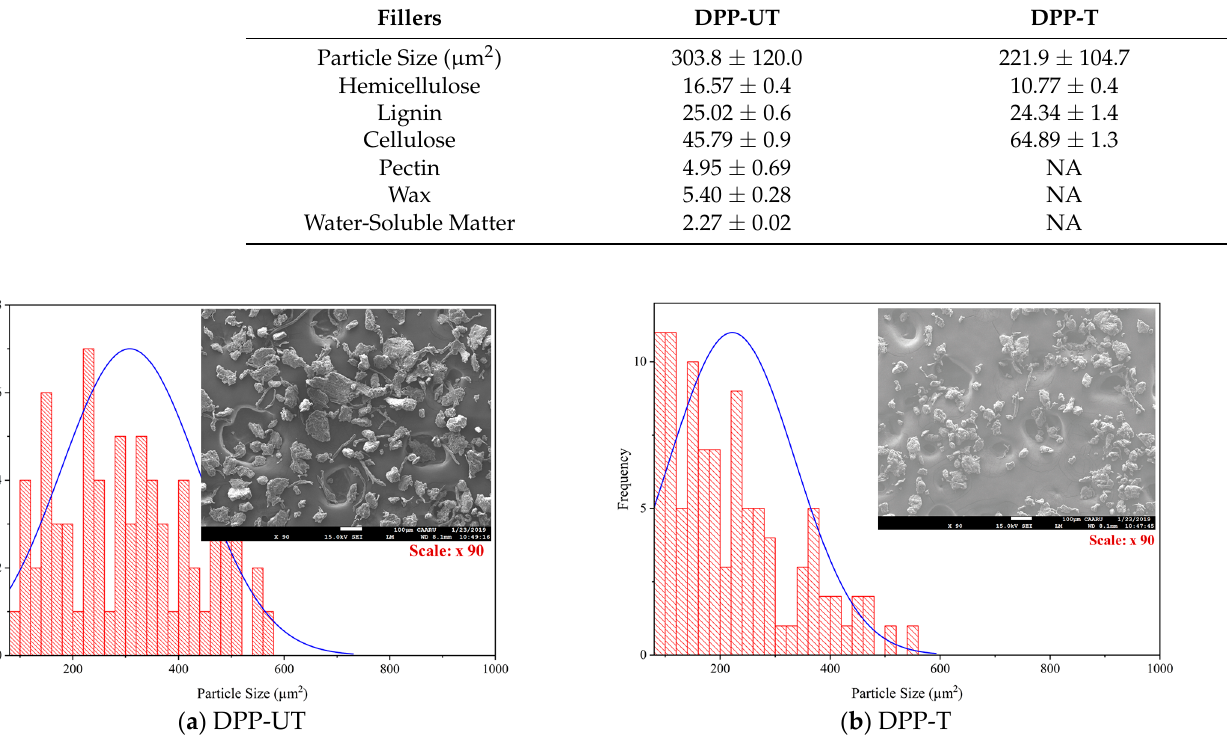
Figure 1. Particle size measurement and distribution: ( a ) DPP-UT; ( b ) DPP-T. Table 1. Chemical compositions (%) of untreated and treated date palm powders (NA: not applicable).